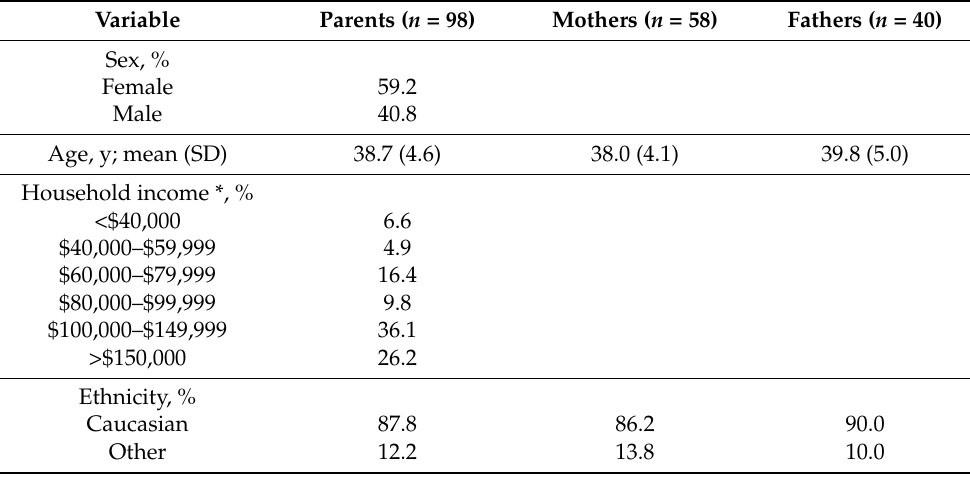
Table 1. Characteristics of mothers and fathers in the Guelph family health study